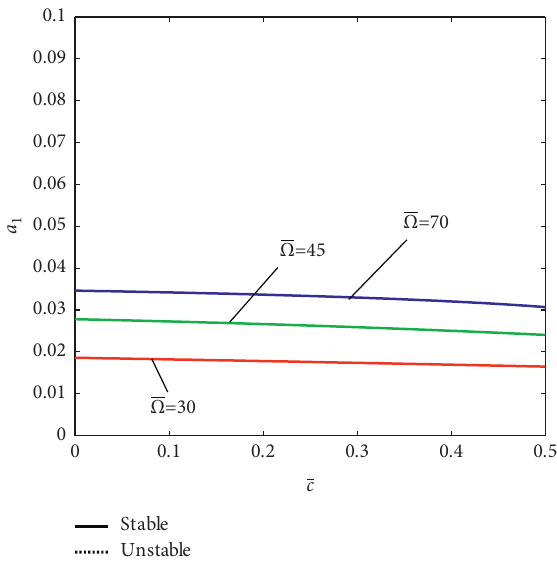
Figure 12: Amplitude versus damping coefficient with different cutting force coefficients (L/d � 10, σ � 2, θ � 0 ° , case I).